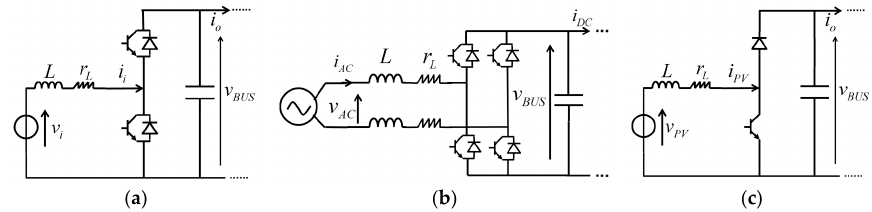
Figure 2. ( a ) Half bridge DC/DC converter; ( b ) Full bridge DC/AC converter ( c ) Basic Boost DC/DC converter.